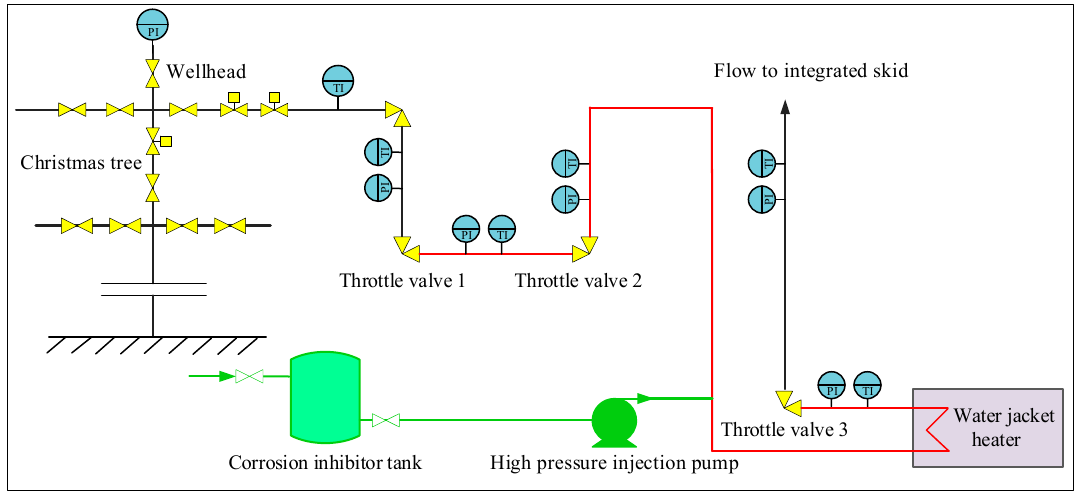
Figure 6. Process flow diagram of well L004-X1 after wellhead throttling optimization.